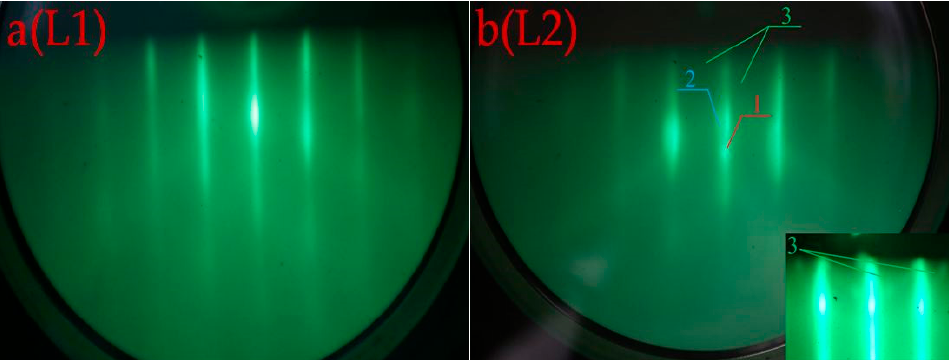
Figure 6. RHEED images after 5 min of irradiating regions L1 ( a ) and L2 ( b ) with electrons.